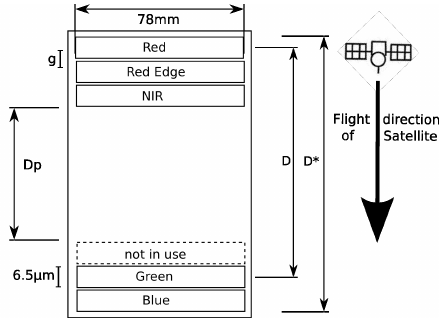
Figure 4: RapidEye focal plane assembly (FPA), g : gap between lines, D p : distance between packages, D ∗ : maximum distance between lines, D : distance